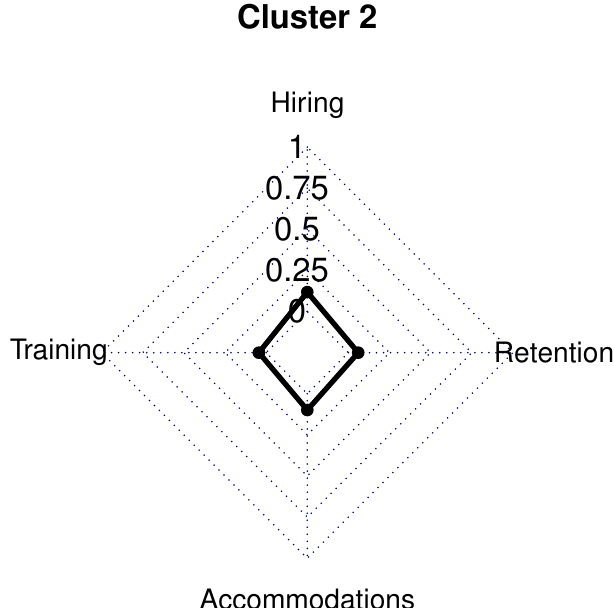
Figure 3. Cluster 2 radar